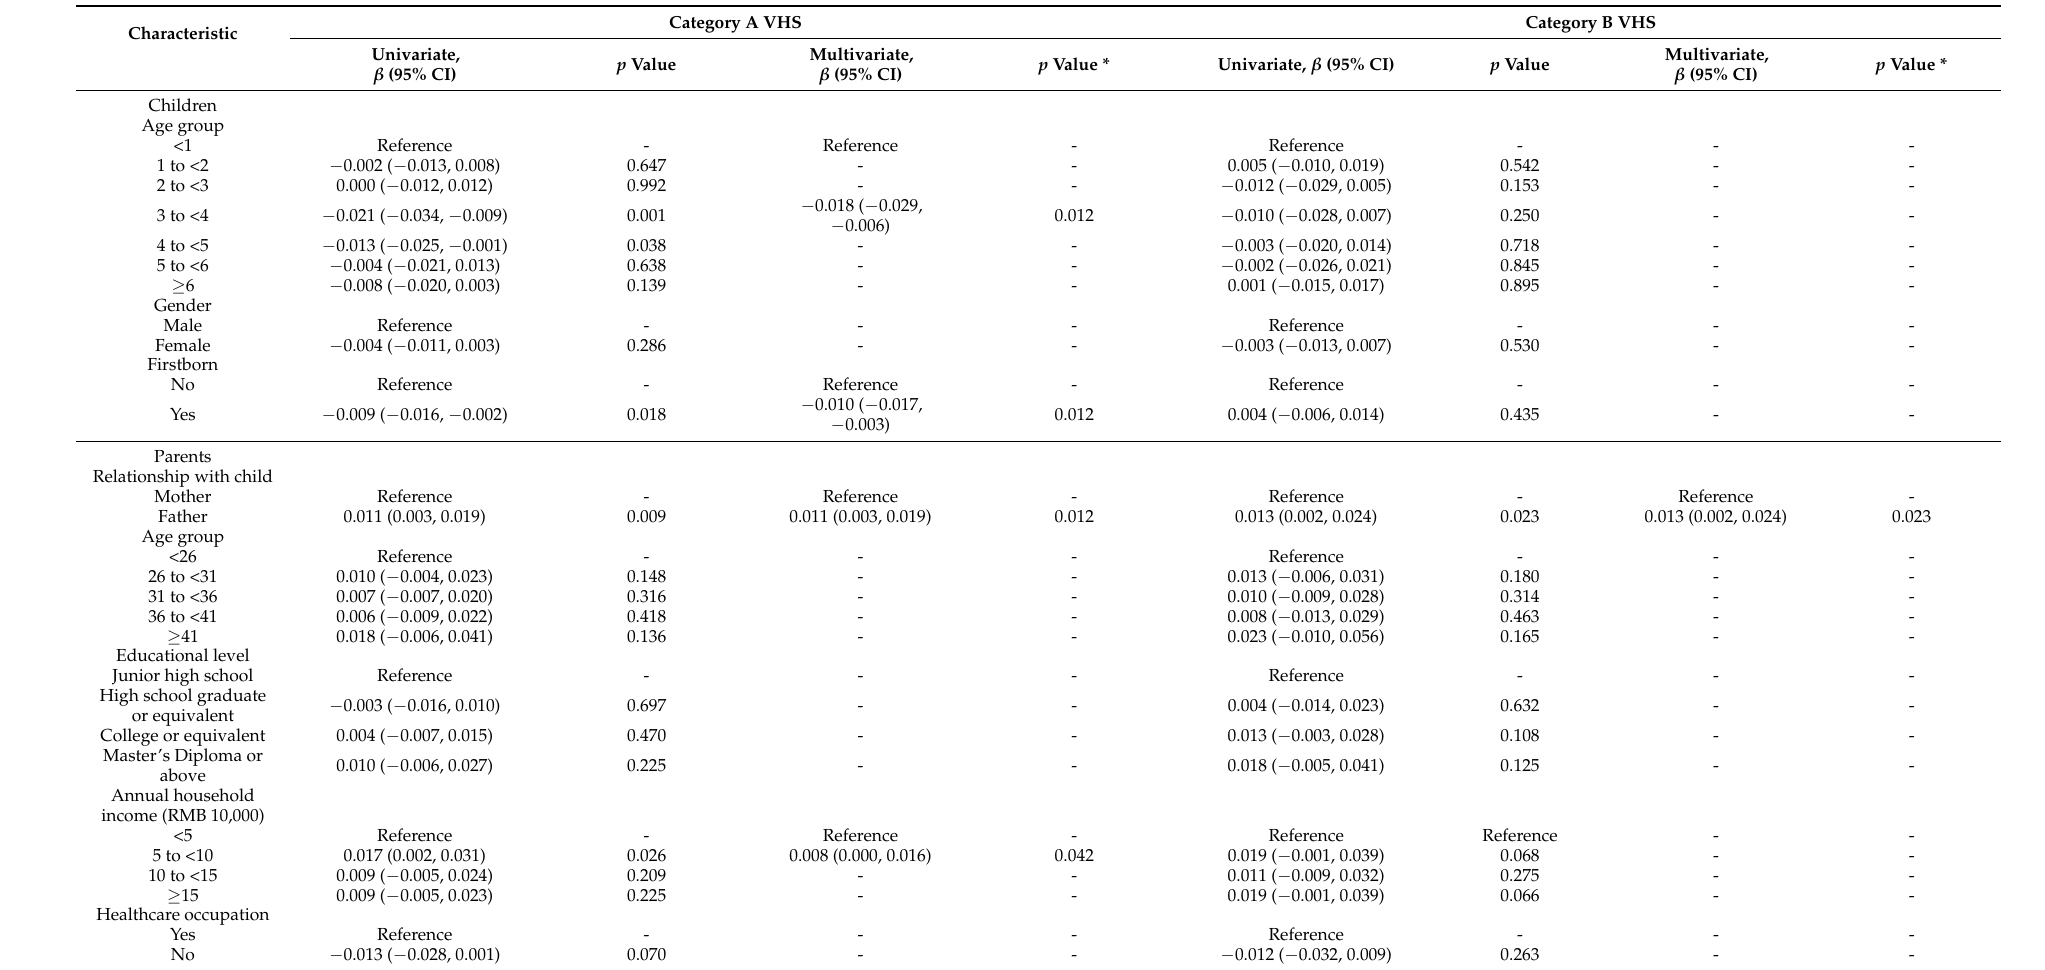
Table 3. Univariate and multivariate factors of parental category A and B vaccine